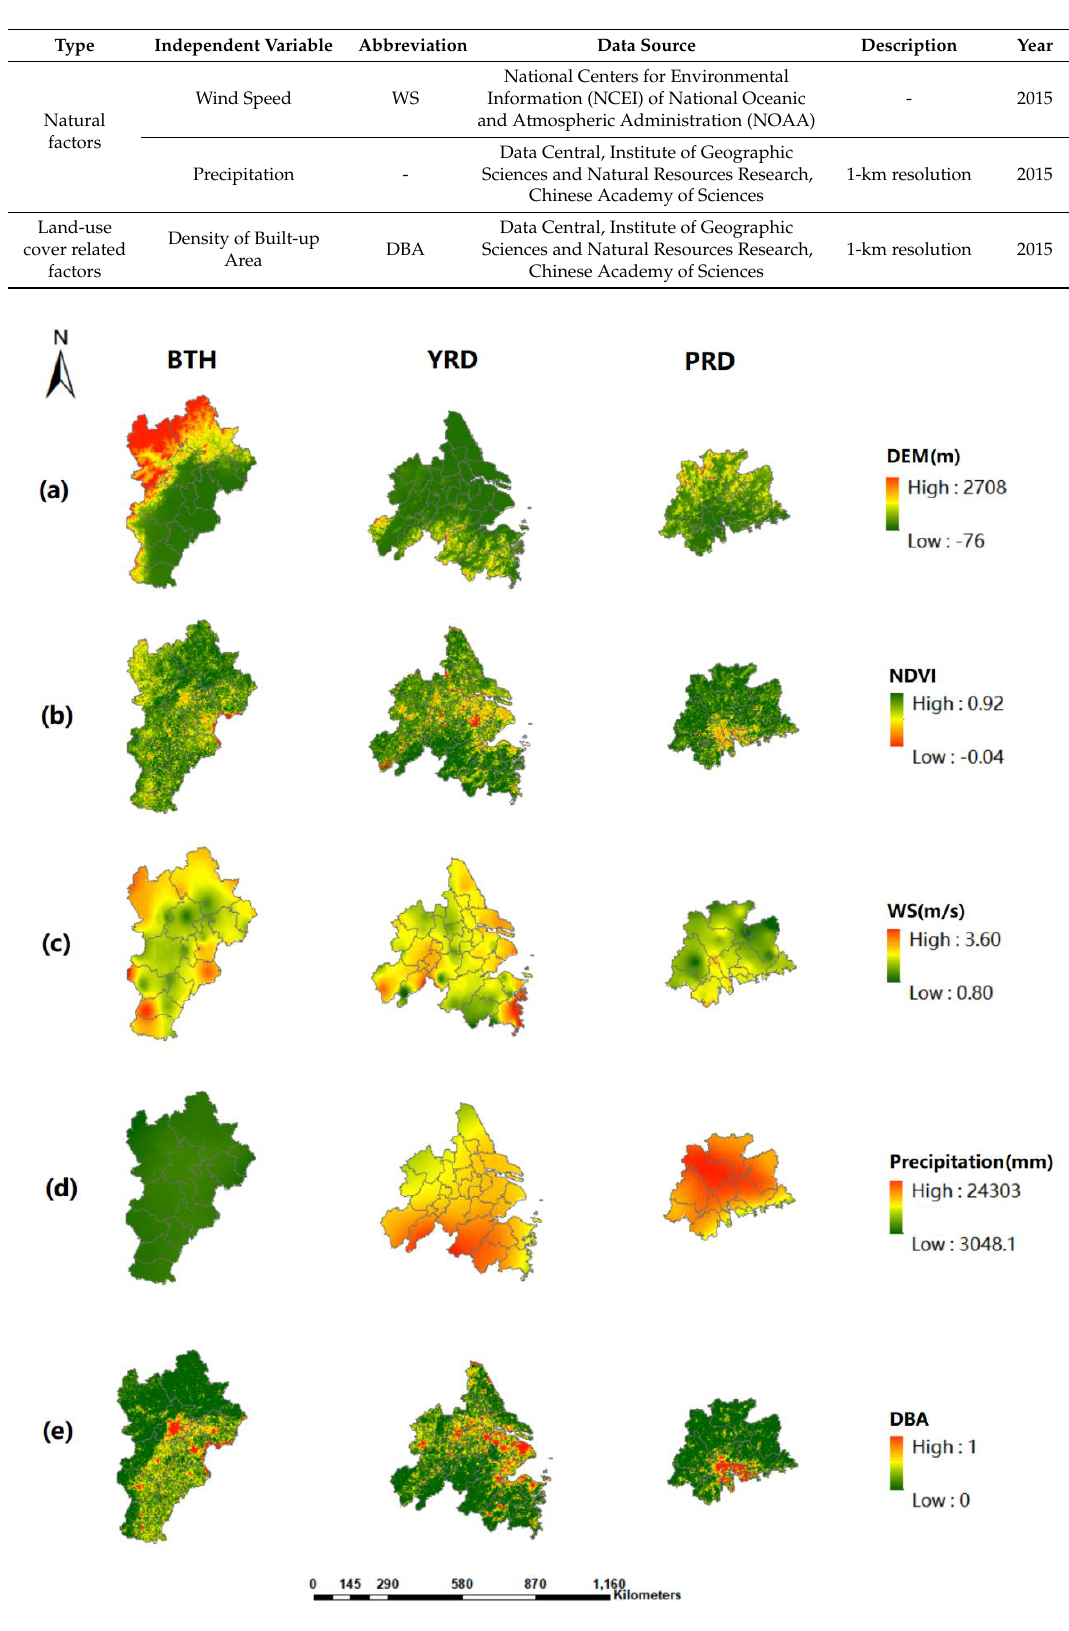
Figure 2. Spatial distribution of potential factors in